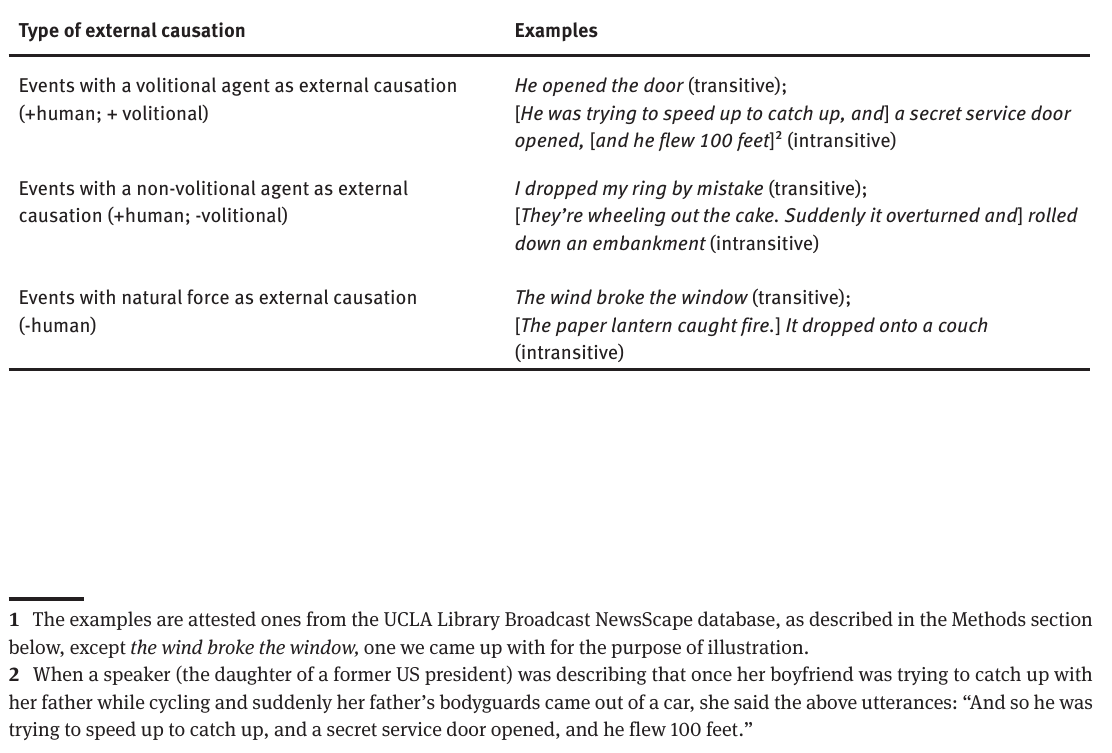
Table 1. Events with various types of causation and their